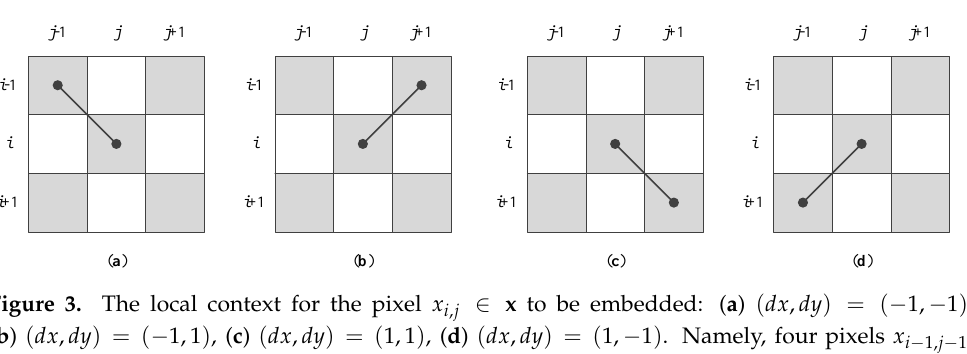
Figure 2. Three prediction modes for the pixel x i , j ∈ x to be embedded: ( a ) Horizontal prediction, ( b ) Vertical prediction, ( c ) Four-direction prediction. For example, in ( a ), x i , j will be predicted with x i , j − 1 and x i , j + 1 , and the prediction equation can be found in Equation (4).